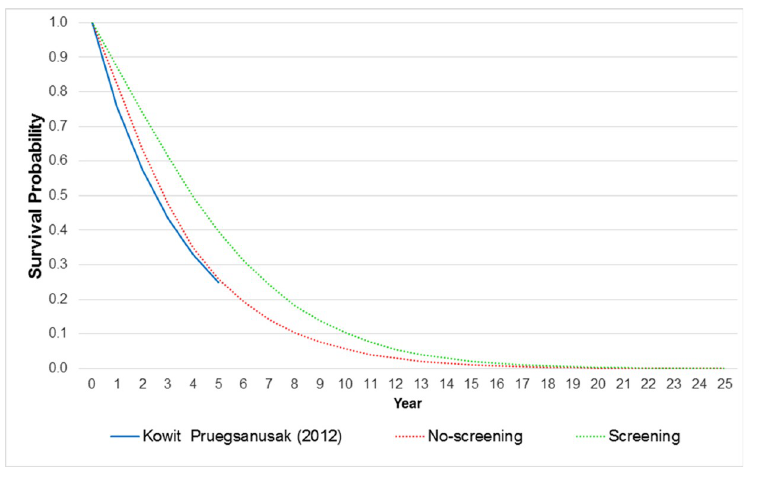
Fig 2. Model validation.